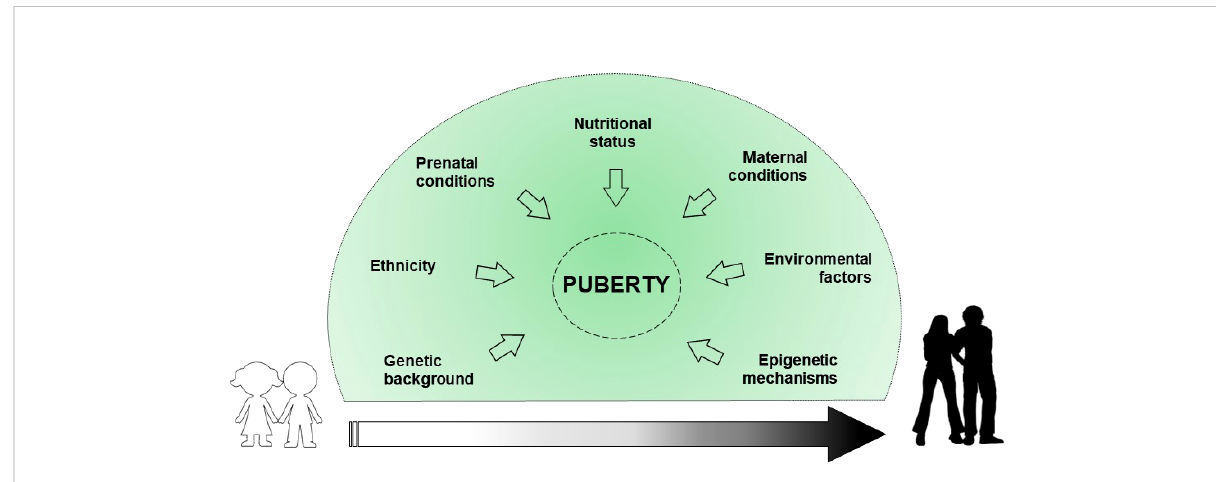
FIGURE 1 Exogenous and endogenous factors involved in the regulation of the puberty